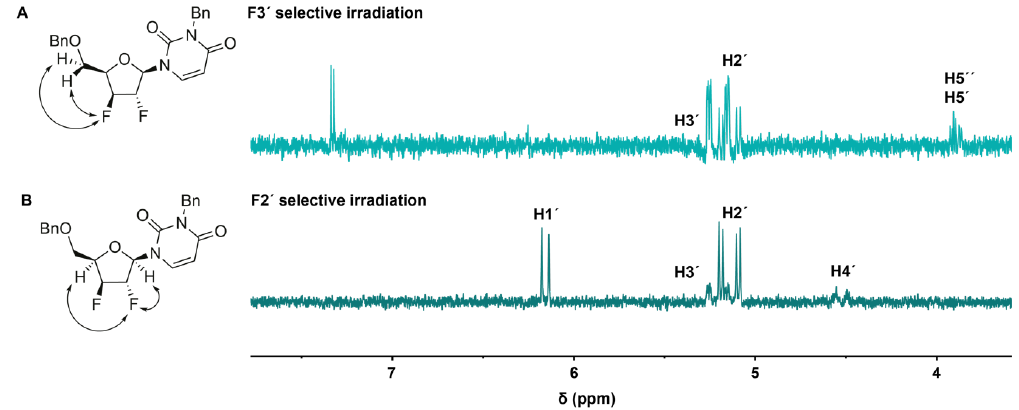
Figure 2. Heteronuclear NOE experiments (HOESY) for compound 13 (282 MHz, CDCl 3 ). The mixing time of the experiment was 600 ms. ( A ) Selective irradiation of the F3′. ( B ) Selective irradiation of the